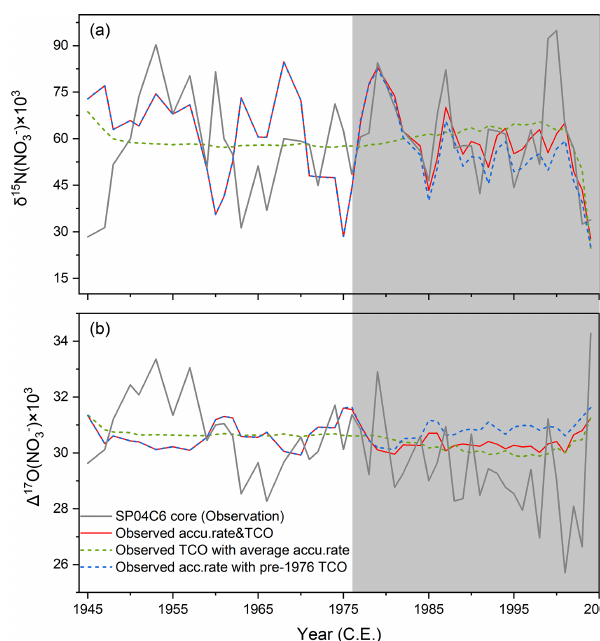
Figure 4. Sensitivity results of the modeled isotopes, i.e., δ 15 N(NO − ) (a) and (cid:49) 17 O(NO − ) (b) , to TCO and snow accumula- 3 3 tion rate. Gray curve: ice-core observed record; Red curve: modeled results with observed accumulation rate and TCO; Green curve: modeled results with observed TCO but mean accumulation rate throughout the record; Blue curve: modeled results with observed accumulation rate but TCO was kept the same before and after 1976. Gray area represents the ozone hole